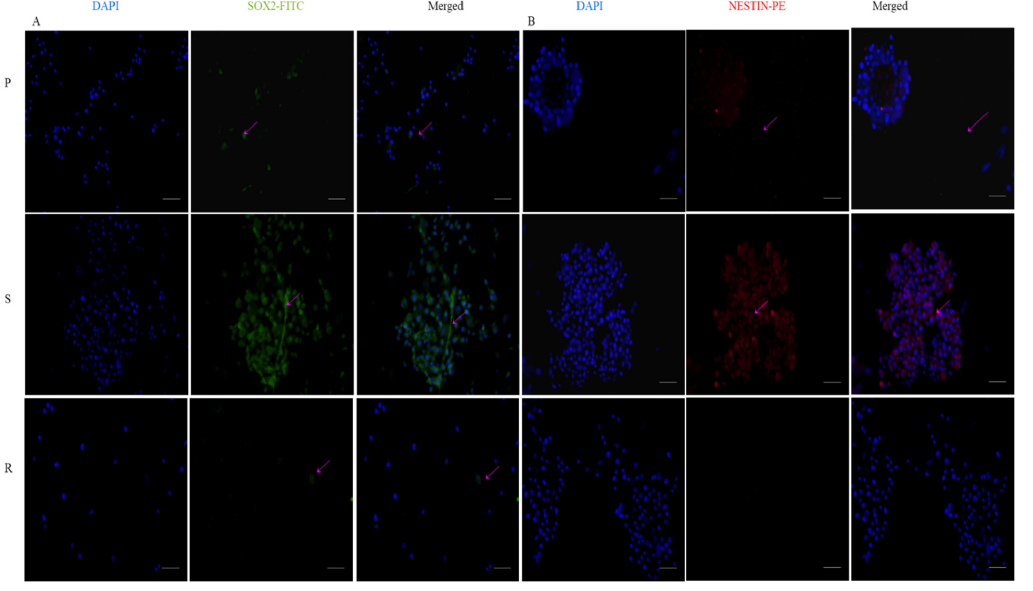
Figure 9. Expression of stemness markers: immunocytochemistry images of ( A ) Sox2 primary anti ‐ body stained with FITC and counterstained with DAPI; ( B ) Nestin ‐ primary antibody stained with PE and counterstained with DAPI. The scale bar indicates 20 μ m.